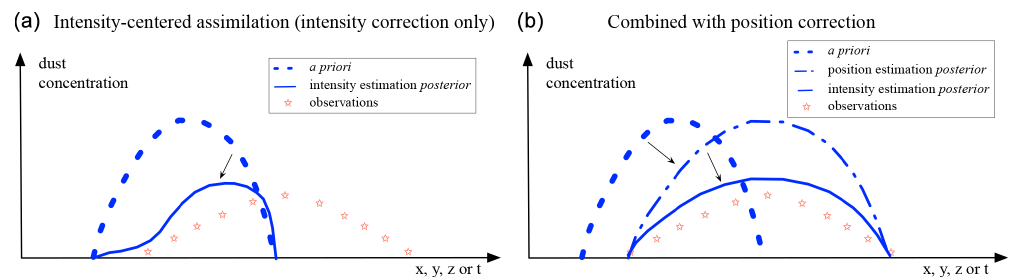
Figure 4. Illustration of intensity-centred assimilation only (a) versus assimilation after position error correction (b)